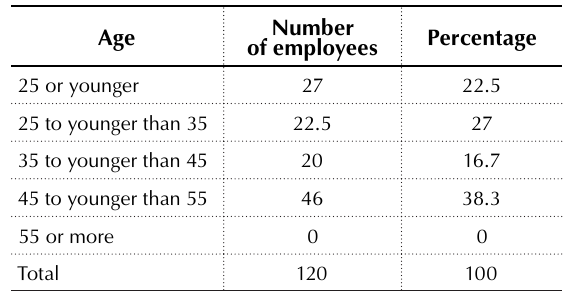
Table 2. Frequency distribution of the